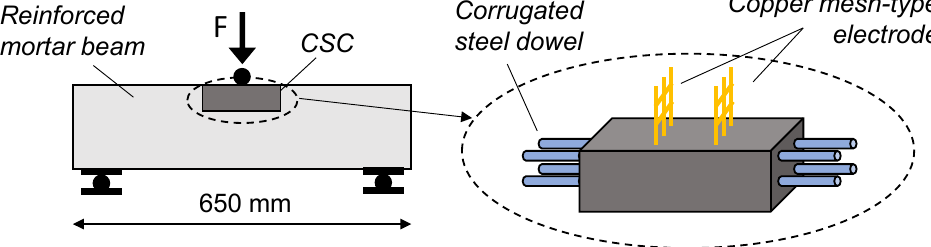
Figure 10. CSC sensor with corrugated steel dowels embedded into beam (adapted from [81]).